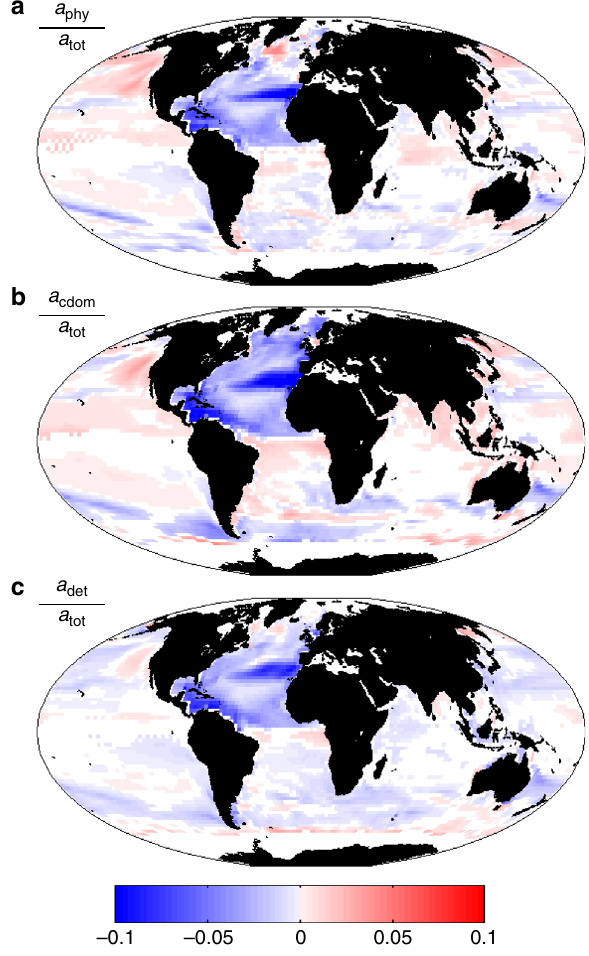
Fig. 7 Change in contribution of optically important constituents. Change between 2085 – 2100 and 1998 – 2015 of a a phy / a tot ; b a cdom / a tot ; c a det / a tot at 475 nm. Absorption is indicated by a : a tot refers to total absorption, a phy to the phytoplankton component of absorption, a cdom to the dissolved organic matter component, and a det to the detrital particle component. Only regions with statistically signi fi cant differences ( p < 0.05) between the two sample periods are shown. In addition, we only show regions that were ice free for most of the